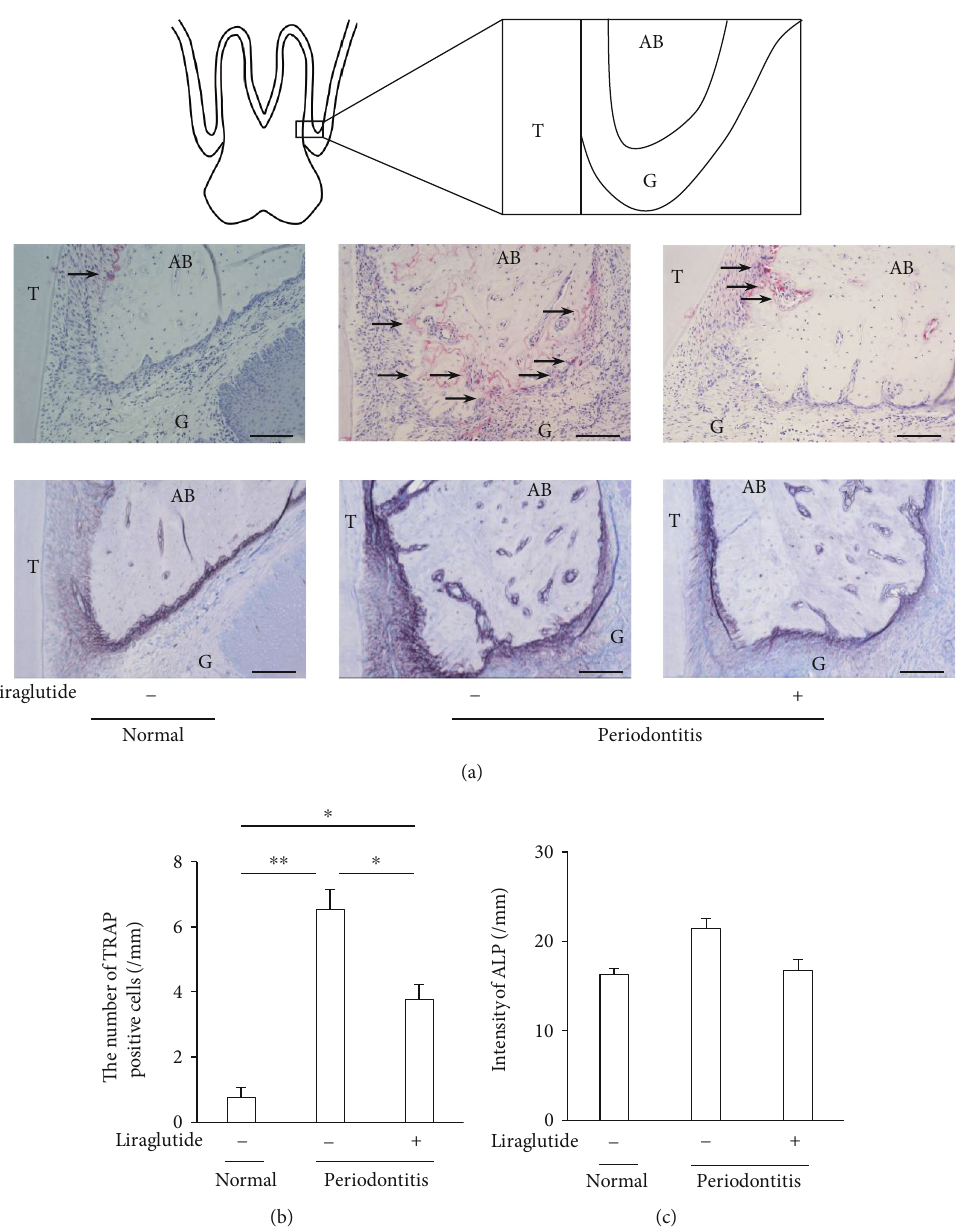
Figure 4: Evaluation of osteoclast formation and osteoblast activity on the surface of alveolar bone. Histologic sections were obtained 14 days after ligation and administration of liraglutide. (a) Upper panels: pattern diagrams of anatomical aspects of alveolar tissues. T: tooth; G: gingiva; AB: alveolar bone. Middle panels: TRAP-positive osteoclast localization in the second molar of the maxillary frontal sections; the black arrows mark the TRAP-positive cells. Scale bar = 100 μ m. Lower panels: ALP staining of the same part as upper panels. Scale bar = 100 μ m. (b) Quanti fi cation of TRAP-positive cells (osteoclast) (nuclei of ≧ 3). (c) Quanti fi cation of ALP (activity of osteoblasts) by ImageJ. The results are expressed as the mean ± SEM ( n = 3 ). ∗ P < 0 : 05 and ∗∗ P < 0 : 01